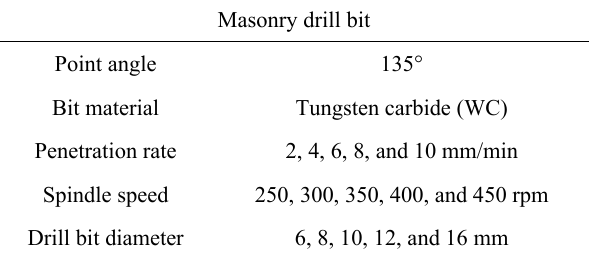
Table 1 Specification of the drill bit used, along with the process parameter and their